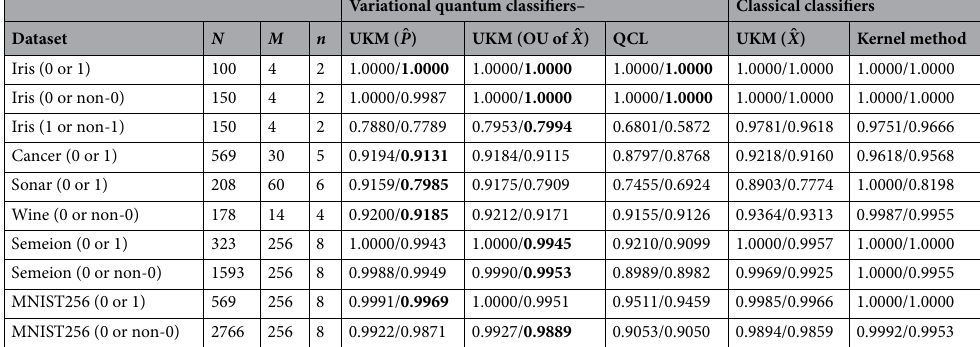
1d Heisenberg, w/o bias